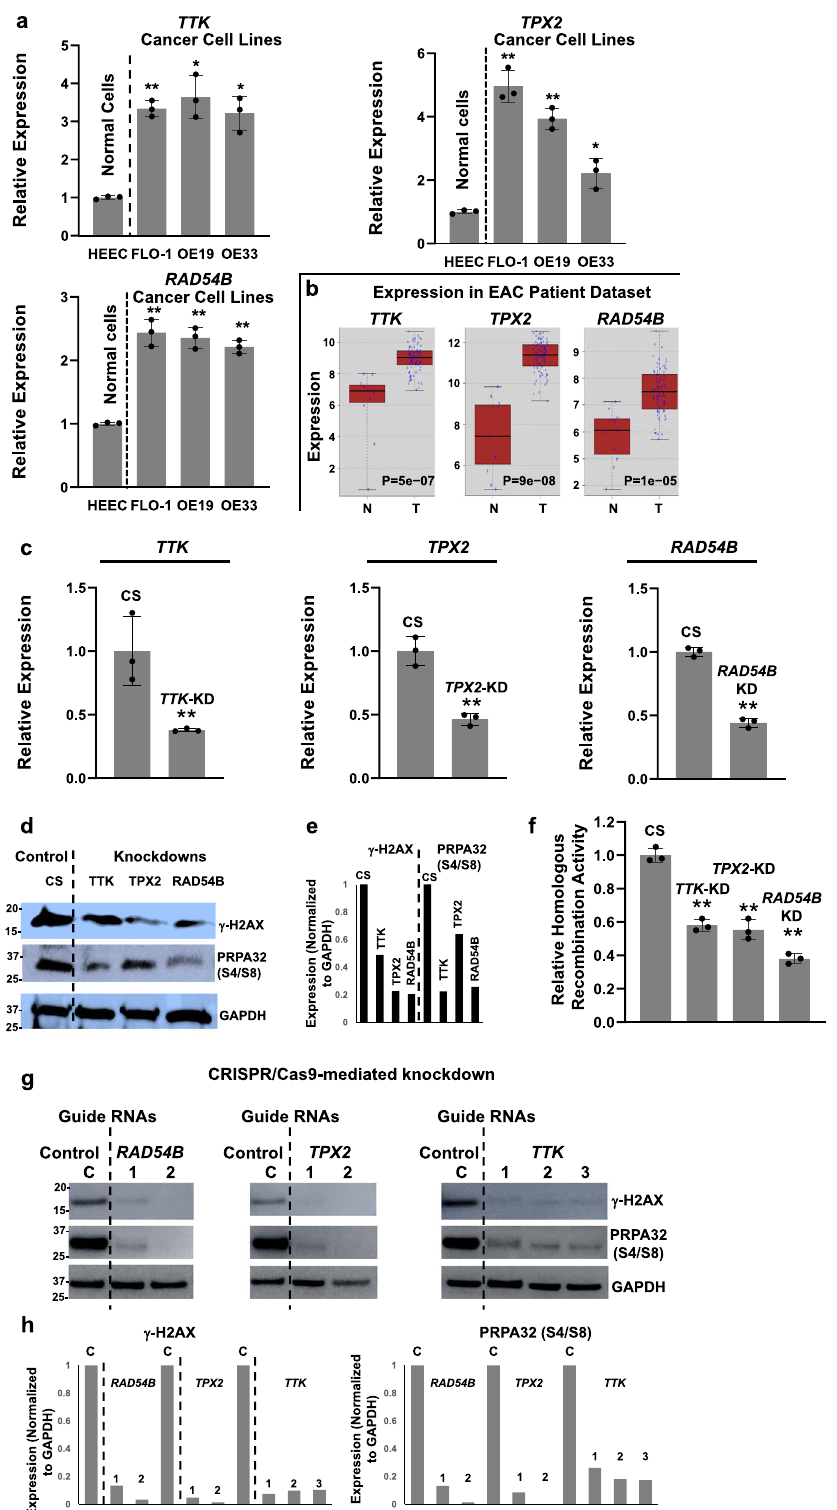
were treated with TTK inhibitor at various concentrations for 72 h and cell viability assessed. IC50 values of the inhibitor was much higher for non-cancerous cells (HEsEpi, 252 μ M; Het-1A, 5.5 μ M; HDF, 3.6 μ M), whereas 1.0 μ M for all three EAC cell lines (Fig. 6a). To evaluate the ef fi cacy of TTK inhibitor in vivo, FLO-1 cells were injected subcutaneously in SCID mice and, following the appearance of palpable tumors, mice treated with the drug.